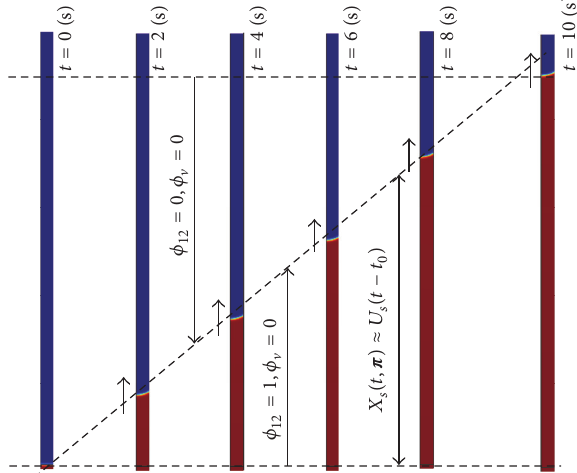
Figure 17: Evolution of the fraction volume of fluid to illustrate the front interface Γ 1 of the slug at the sequence of times (𝑡 𝑘 ) 𝑘∈[1,5] = (2𝑘) 𝑘∈[0,5]